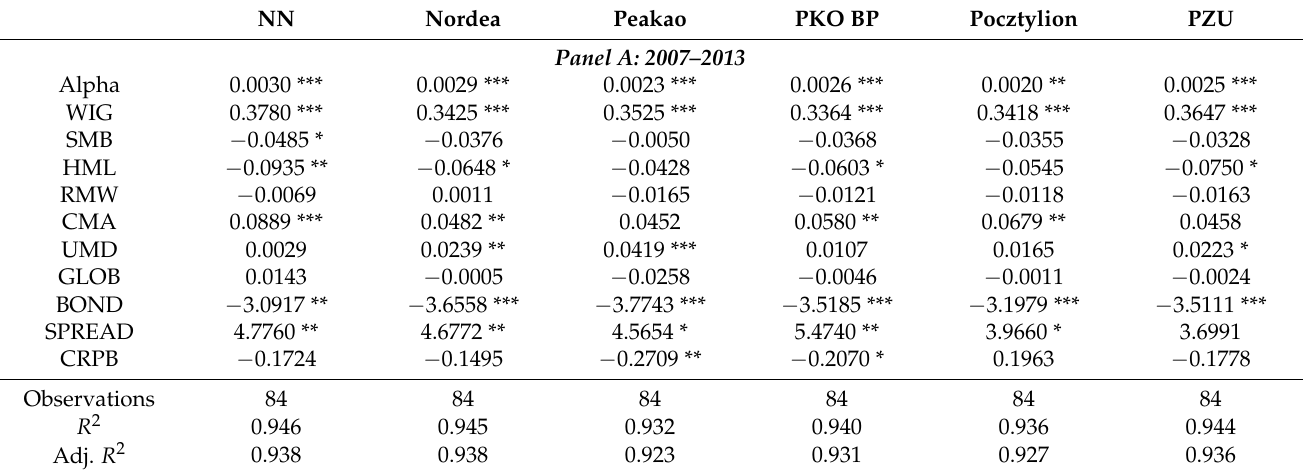
Table 6. Performance of individual OPF portfolios (part